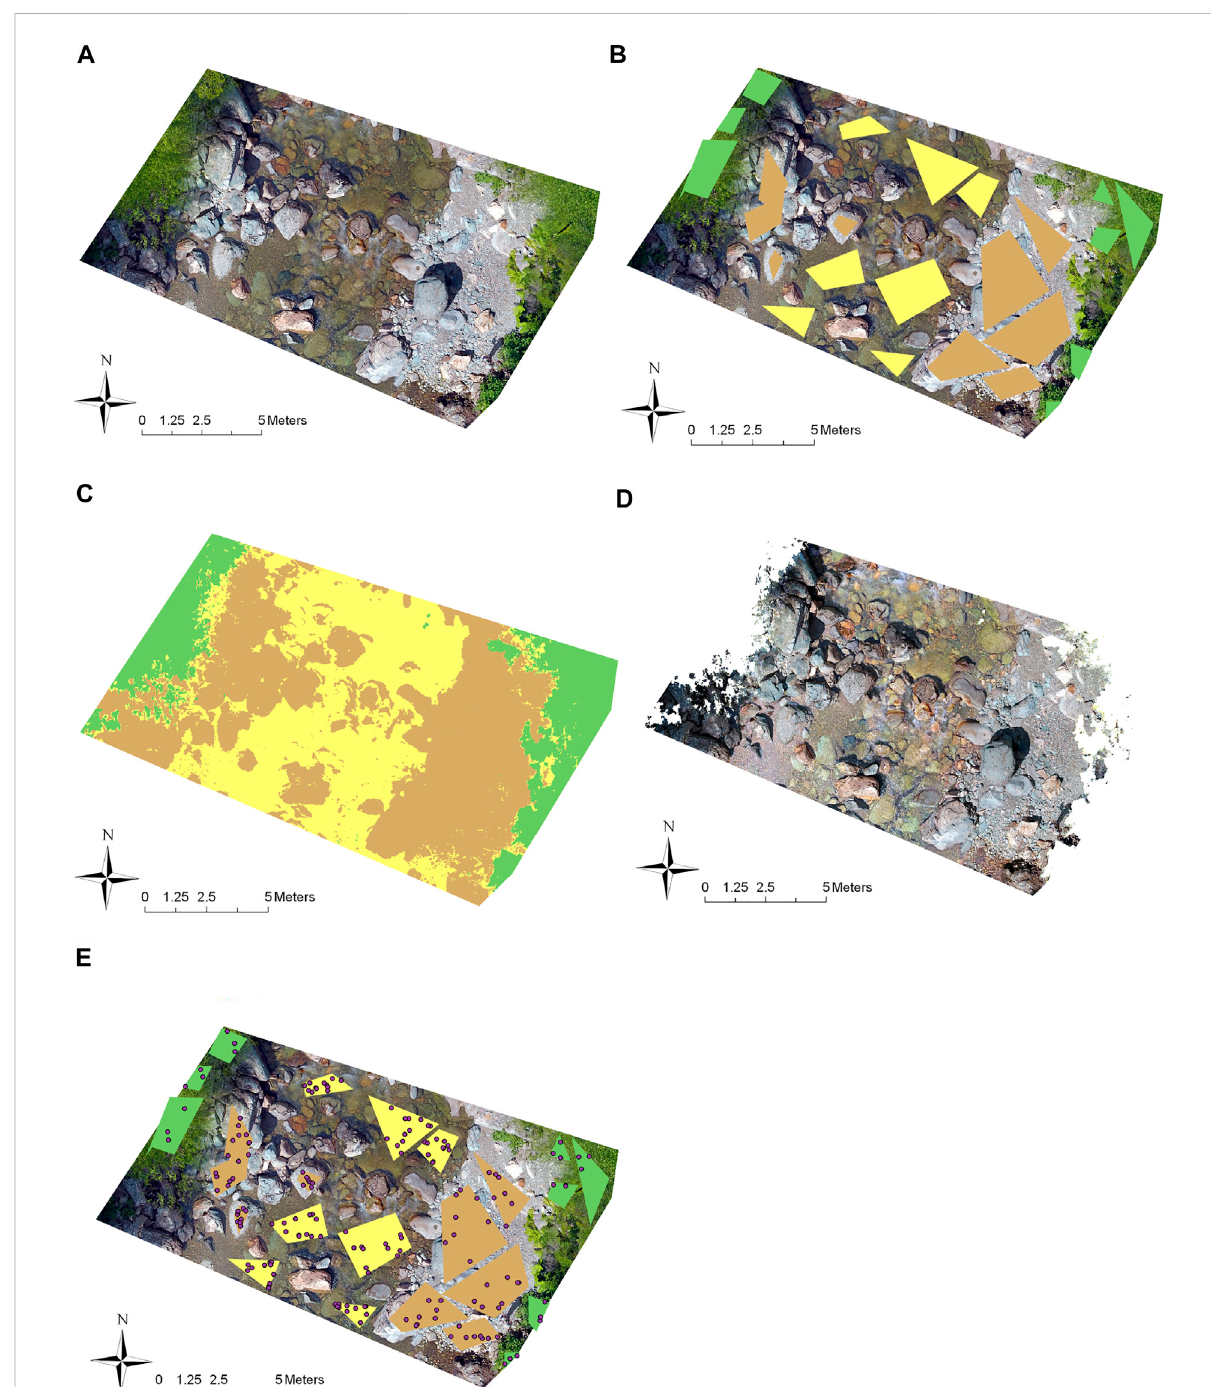
FIGURE 4 Exampleoftheprocessofclassifyingsubstrate(transect3). (A) Droneimageryofthetransect. (B) Selectedtraining sitesshowingtheRV(green), dry (brown) and submerged(yellow) polygons. (C) Resulting classi fi edshape fi les used to extract dry (brown)and submerged substrate (yellow) from theRV(green). (D) RasterlayerwiththeRVareasremoved. (E) Examplefromtransect3ofrandompointselectionchosenbytheArcGIStoolsetwithin the training areas used to produce the error matrix. The accuracy point is omitted from training and their predicted value compared to the polygon designation. Green polygons are vegetation, brown polygons are dry substrate and yellow polygons are the submerged